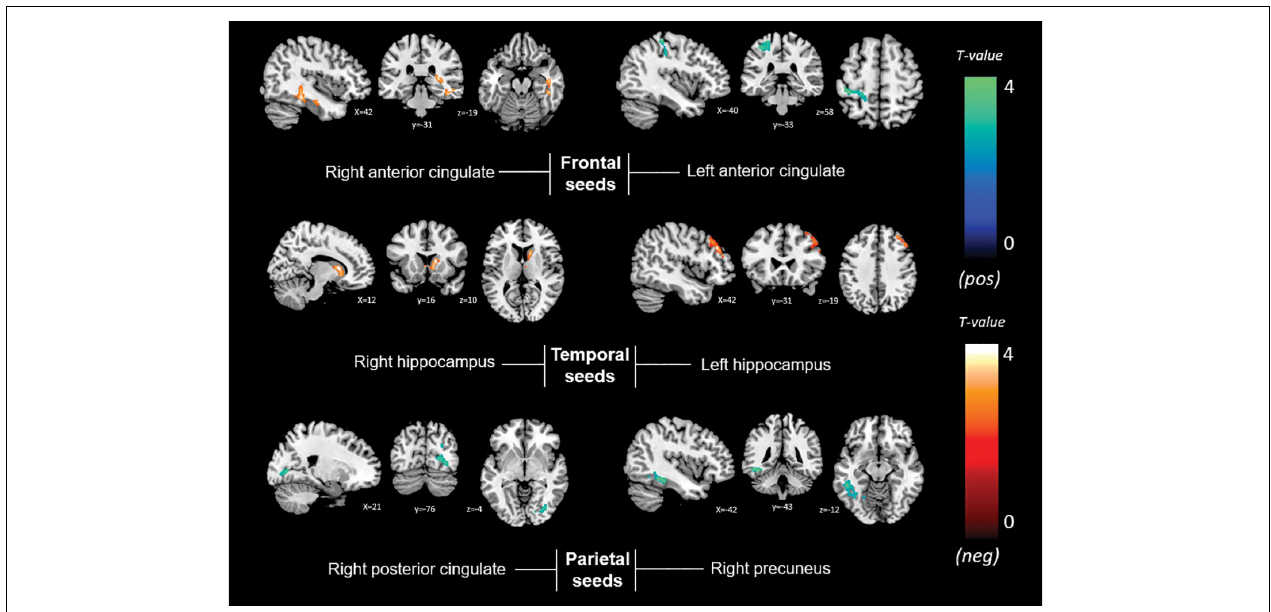
FIGURE 4 | Positive (blue) and negative (red) correlations between brain functional connectivity of selected unilateral seed regions and memory anosognosia